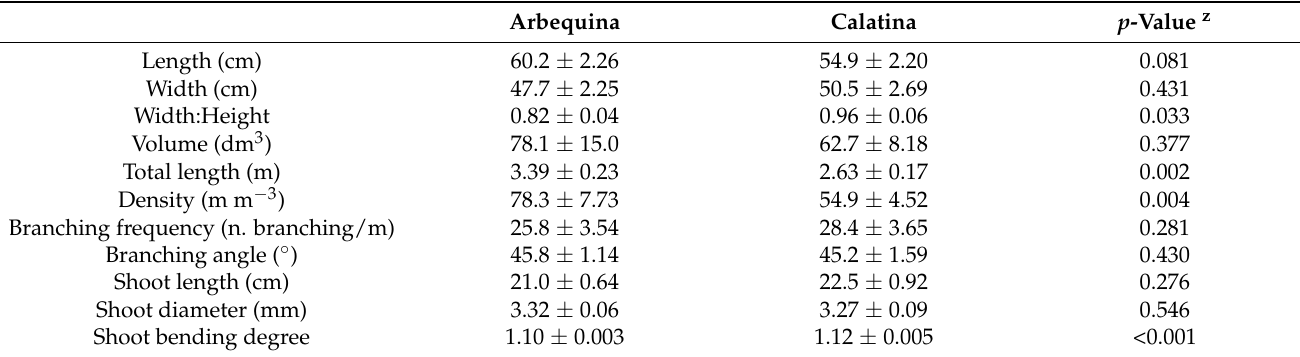
Table 3. Branch and shoot size and architecture in two-year-old bearing branches from ‘Arbequina’ and ‘Calatina’ olive